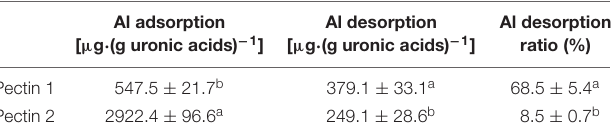
TABLE 1 | Adsorption and desorption of Al in cell wall pectins 1 and 2 of RBCs.